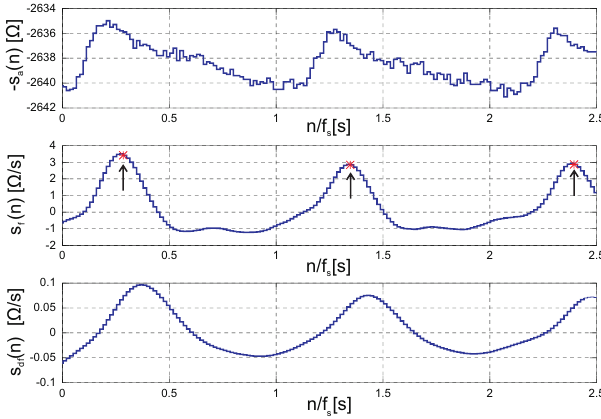
Fig.7: Measured impedance signal s a ( n ) and the filtered signals s f ( n ) and s df ( n ) . The red cross in s f ( n ) mark the maxima which are detected by the